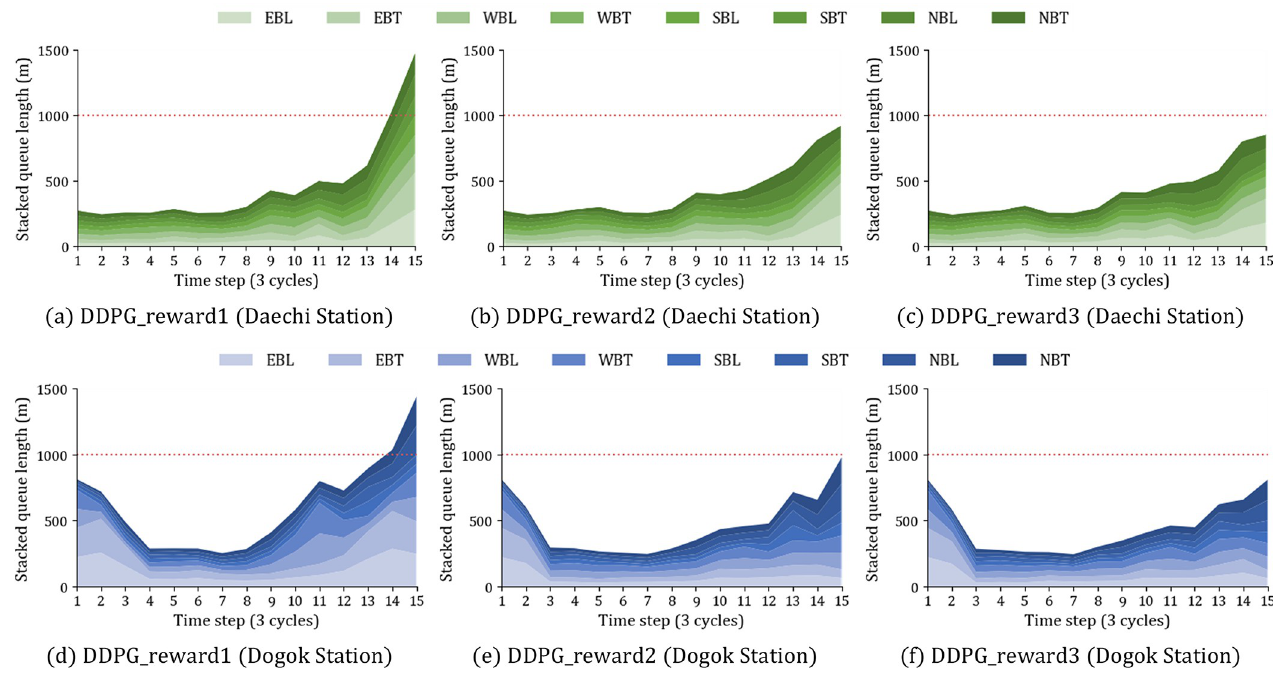
Fig 11. Comparing the stacked queue length of 8 traffic movements for reward definitions. (a) DDGP-reward1 (Daechi Station). (b) DDGP-reward2 (Daechi Station). (c) DDGP-reward3 (Daechi Station). (d) DDGP-reward1 (Dogok Station). (e) DDGP-reward1 (Dogok Station). (f) DDGP-reward1 (Dogok